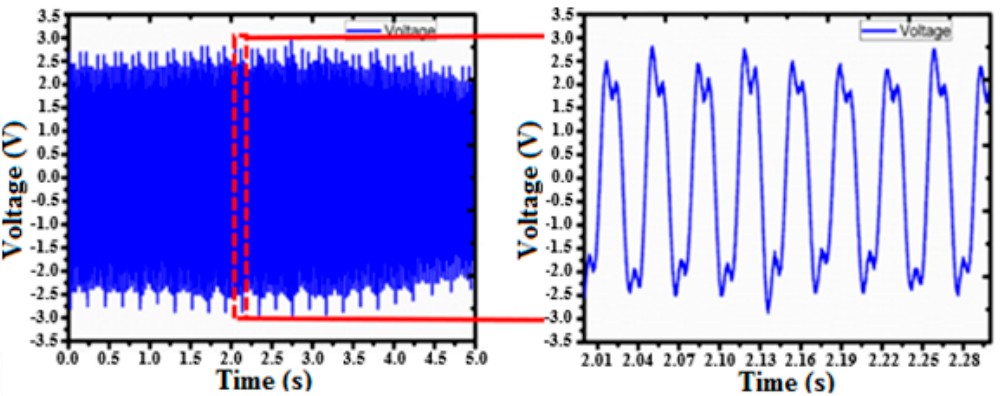
Figure 10. Open circuit voltage analysis of the EMG at a speed of 251 rpm and a temperature difference of 45 °C.